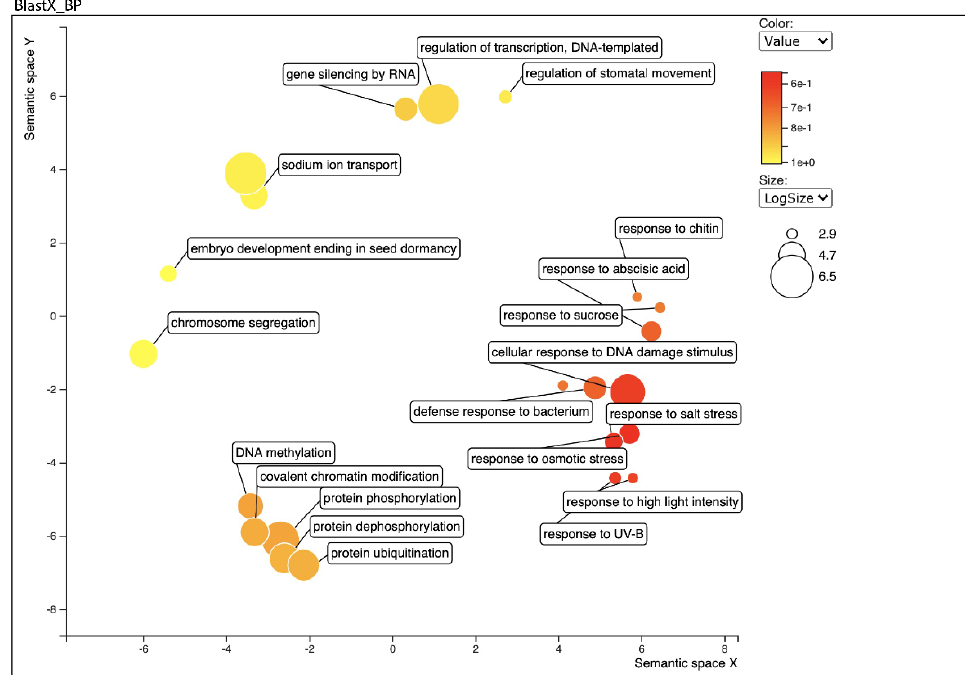
Figure 2. Biological process category of Gene Ontology (GO) enrichment analysis of leaf transcrip- tome BLAST Top-Hits species distribution when compared with nr database using REVIGO. Circles in closer proximity have more closely related GO terms. The size of the circles indicates the number of GO terms. The colour of the circle represents the significance of the enriched GO terms.